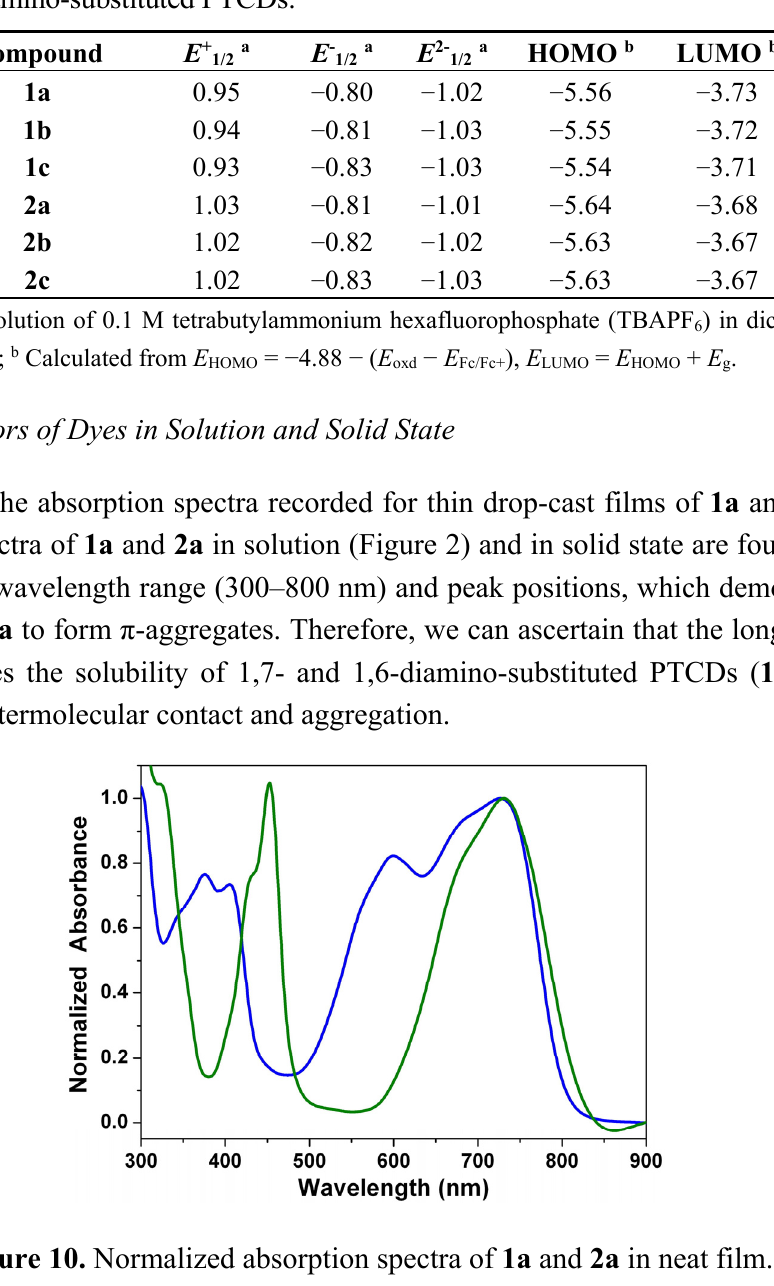
Table 4. Summary of half-wave redox potentials, HOMO and LUMO energy levels for 1,7- and 1,6-diamino-substituted PTCDs.